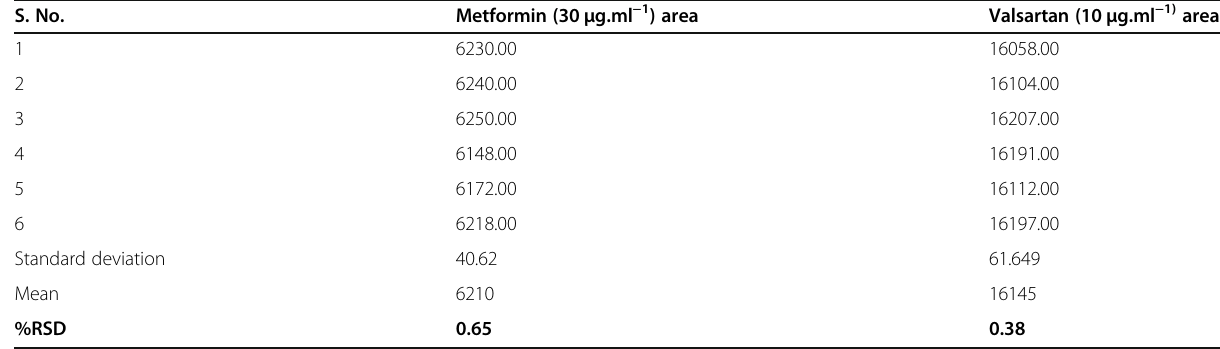
Table 4 Method precision: metformin-valsartan S. No.